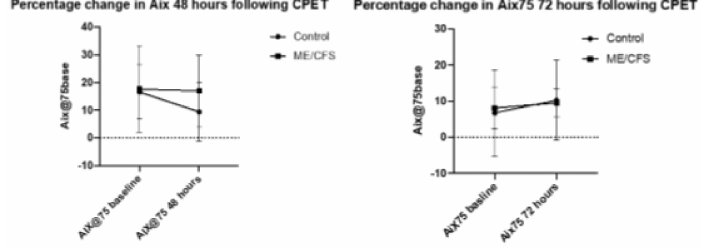
Figure 1. Precentage change in AIx 48 and 72 h following CPET.